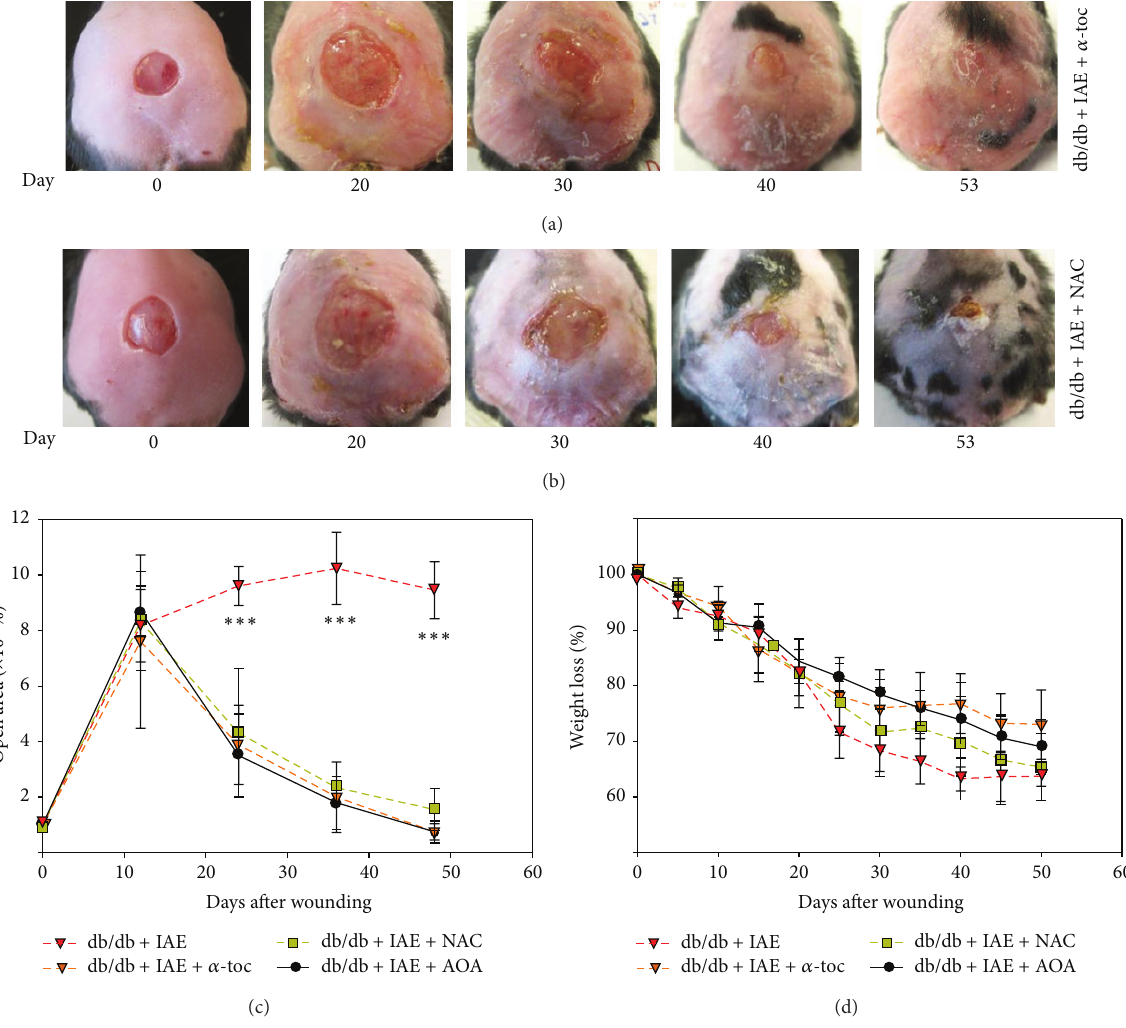
Figure 5: Chronic wounds treated with individual antioxidants. (a) Wound closure in db/db chronic wounds treated with AOA 𝛼 -toc was observed by day 53 after wounding. (b) Wound closure in db/db chronic wounds treated with AOA NAC was observed by day 53 after wounding. (c) Percent open wound area was calculated using Image J. Open area was significantly decreased in db/db wounds treated with IAE and then AOA. (d) Mouse weight loss was significantly higher in animals with no AOA treatment. 𝑛 = 5 . All data are mean ± SD. ∗ 𝑃 < 0.05 , ∗∗ 𝑃 < 0.01 , ∗∗∗ 𝑃 < 0.001